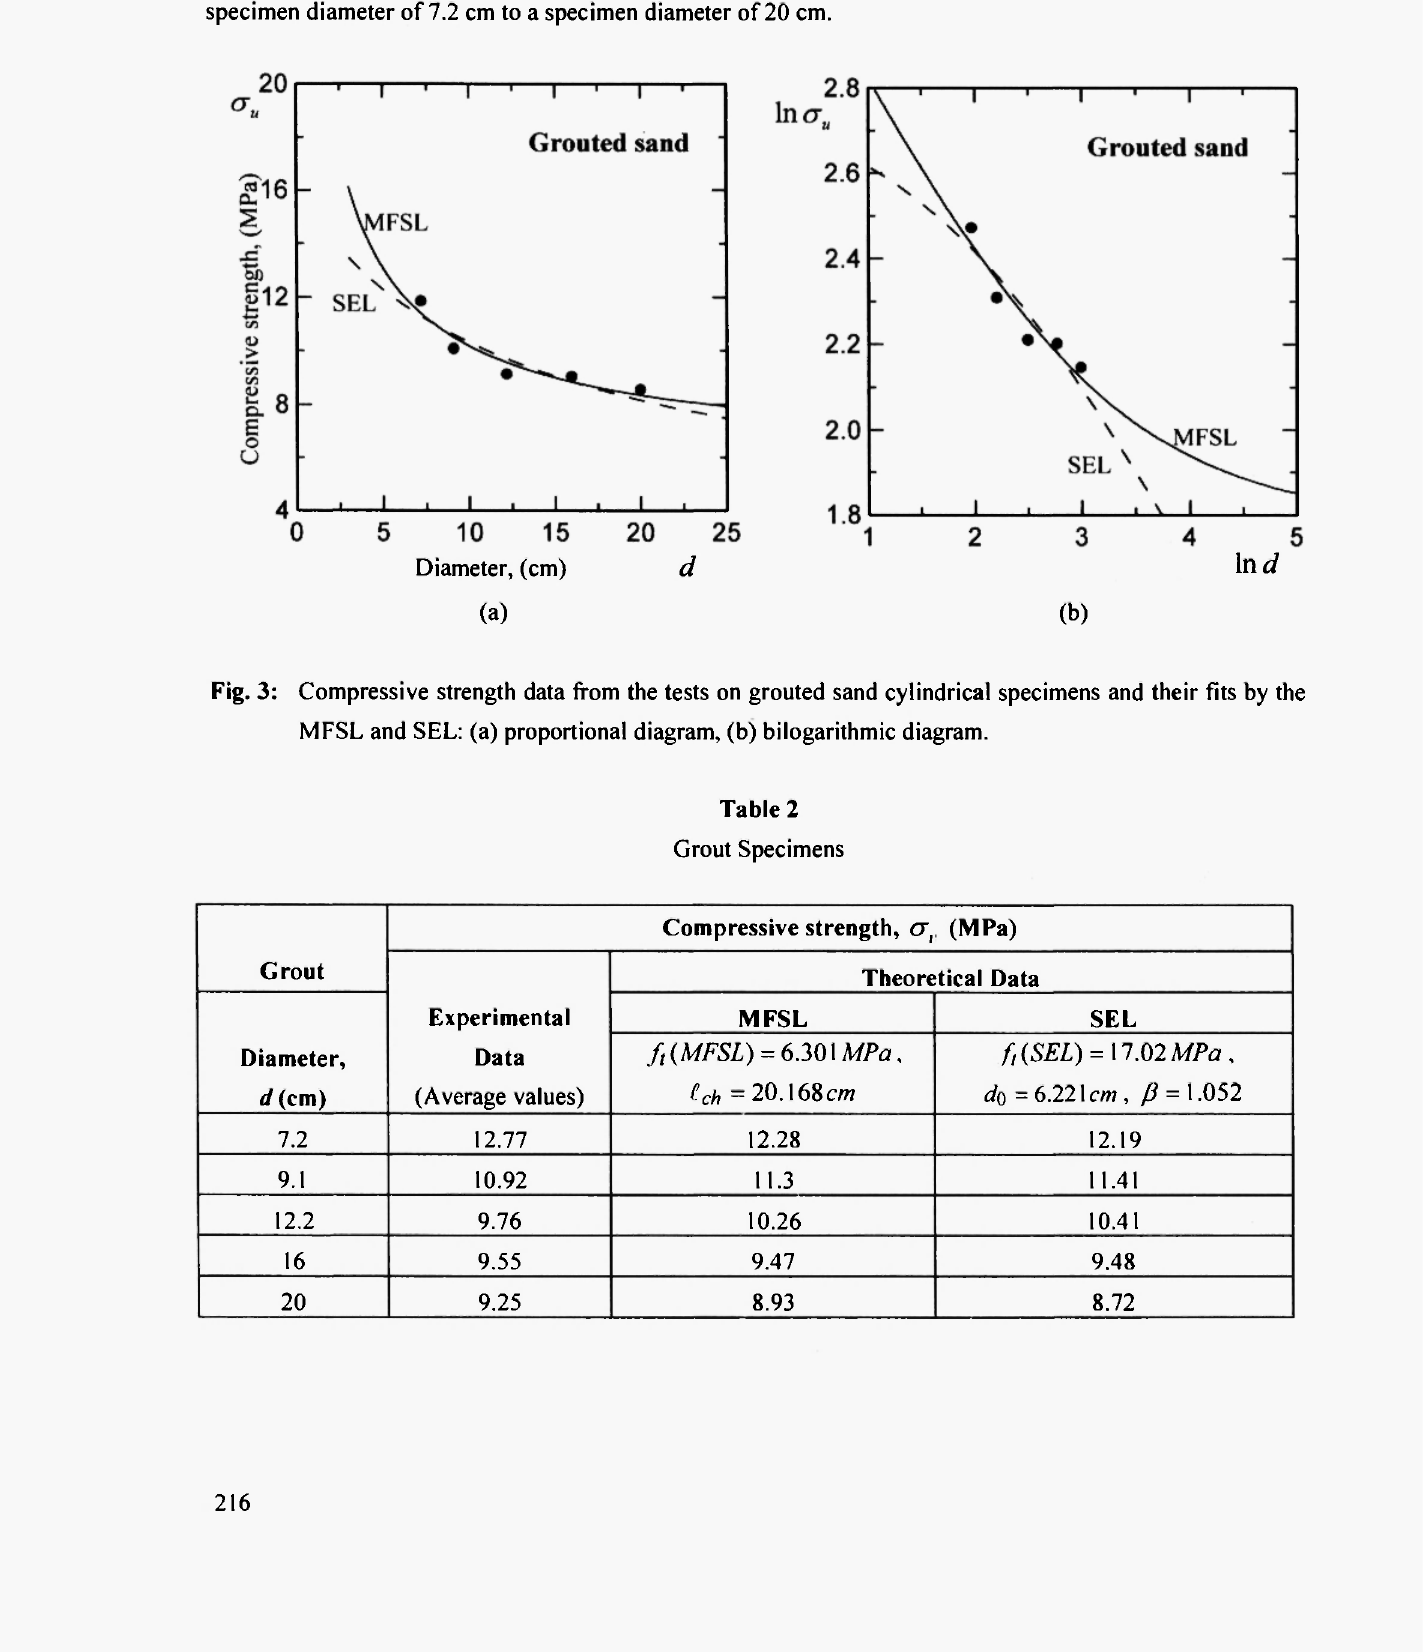
Fig. 3: Compressive strength data from the tests on grouted sand cylindrical specimens and their fits by the MFSL and SEL: (a) proportional diagram, (b) bilogarithmic diagram.